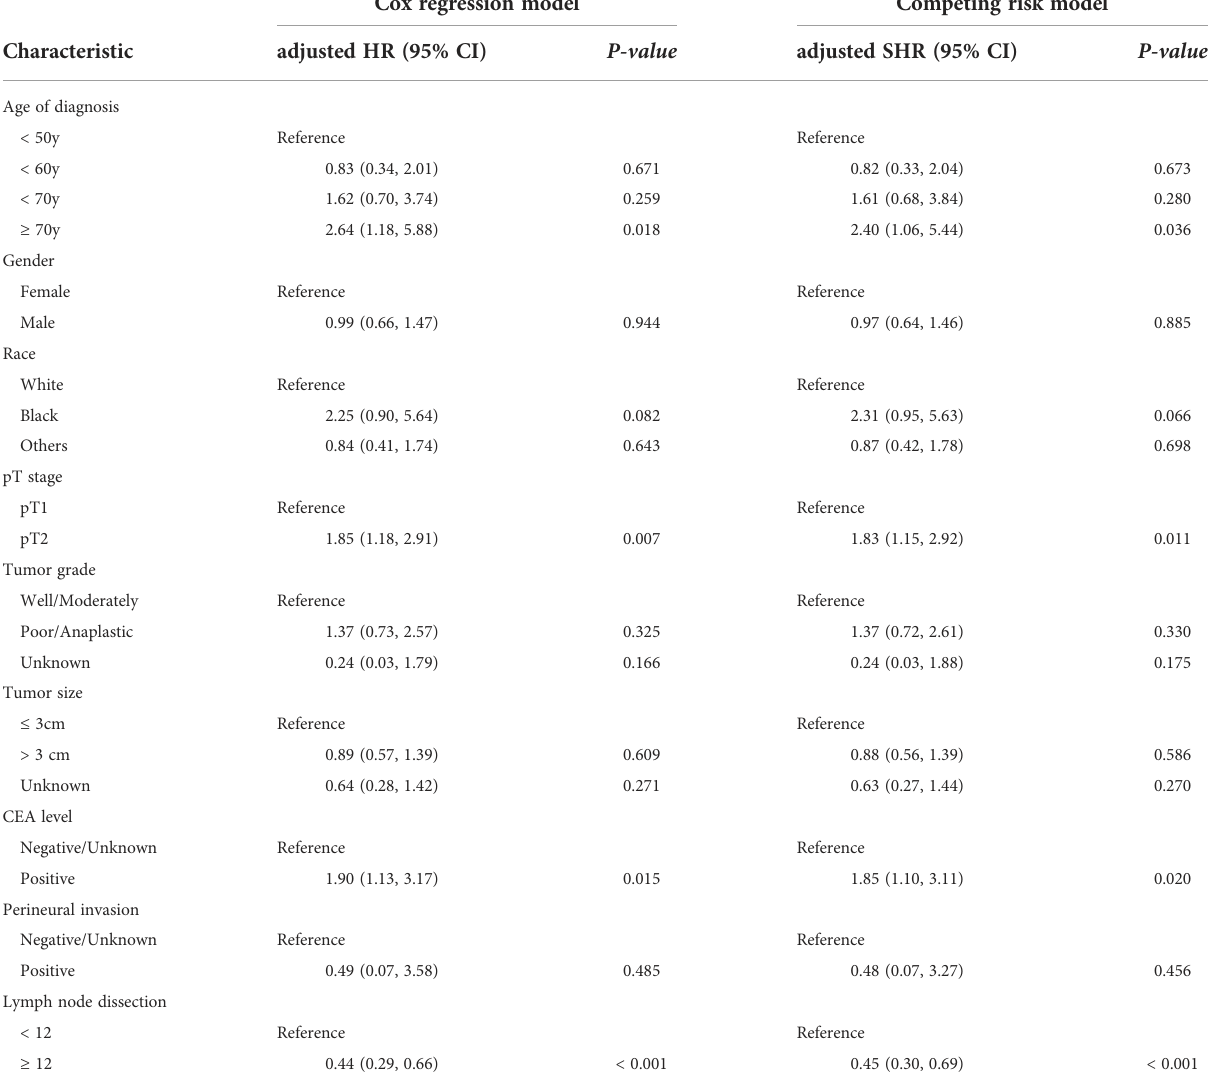
TABLE 2 The predictors of survival for pT1/pT2N0 rectal cancer patients in both multivariate Cox regression model and the multivariate competing risk model. Cox regression